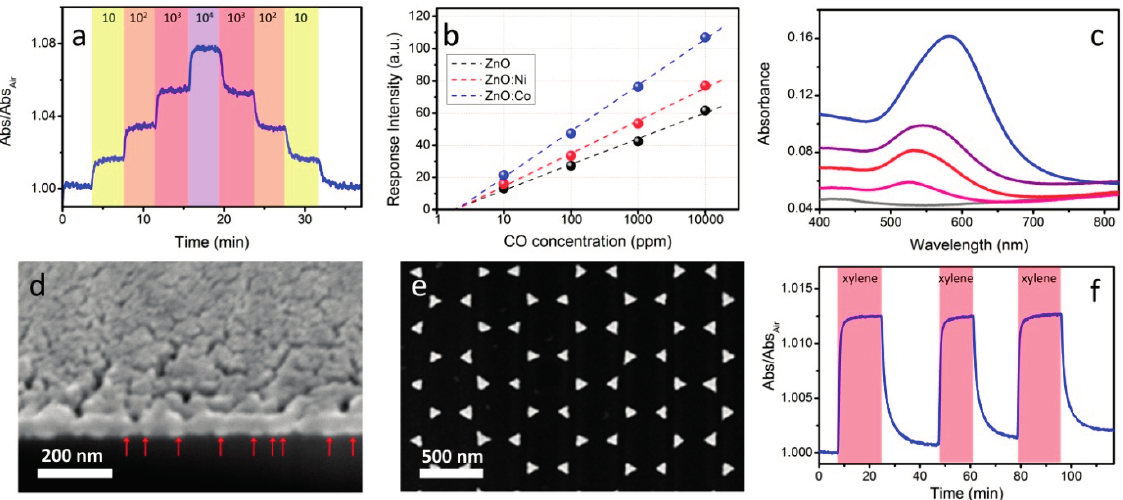
Figure 4. ( a ) Time resolved tests for a ZnO-Au film exposed to different concentrations of CO (in ppm) at 300 °C ( λ = 570 nm); ( b ) Sensitivity plot for ZnO-Au films for CO detection according to the doping of ZnO NPs; ( c ) Optical absorption spectra of Au sub-monolayers with different surface coverage. The color of the spectra is representative of the actual color of the samples; ( d ) SEM image in cross section of a NiO film deposited on Au NP monolayer. The red arrows highlight the Au NPs at the NiO/substrate interface; ( e ) SEM image in top view of an Ag nanoprism array; ( f ) Time resolved measurements of an aryl-bridged polysilsesquioxane films deposited on top of an Ag nanoprism array when exposed to 30 ppm xylene at room temperature ( λ = 653